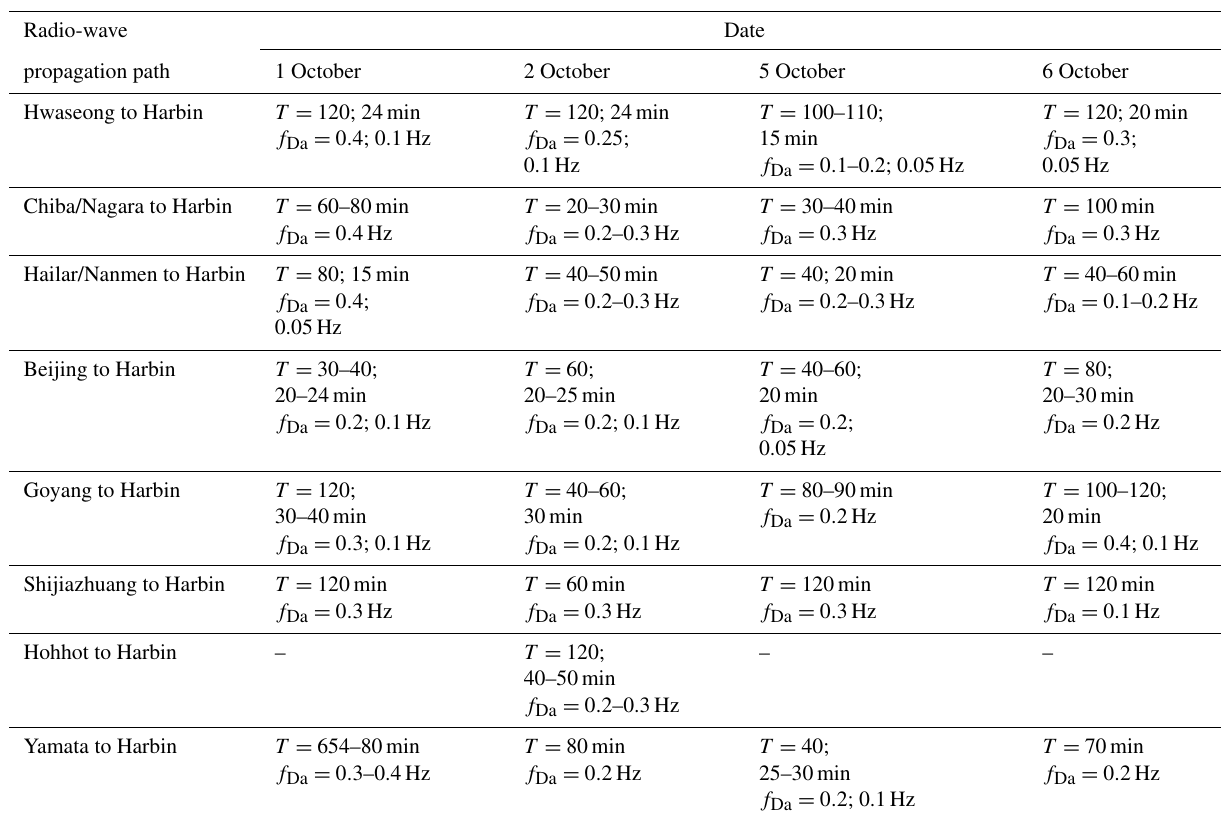
Table 5. Basic parameters of wave disturbances in October